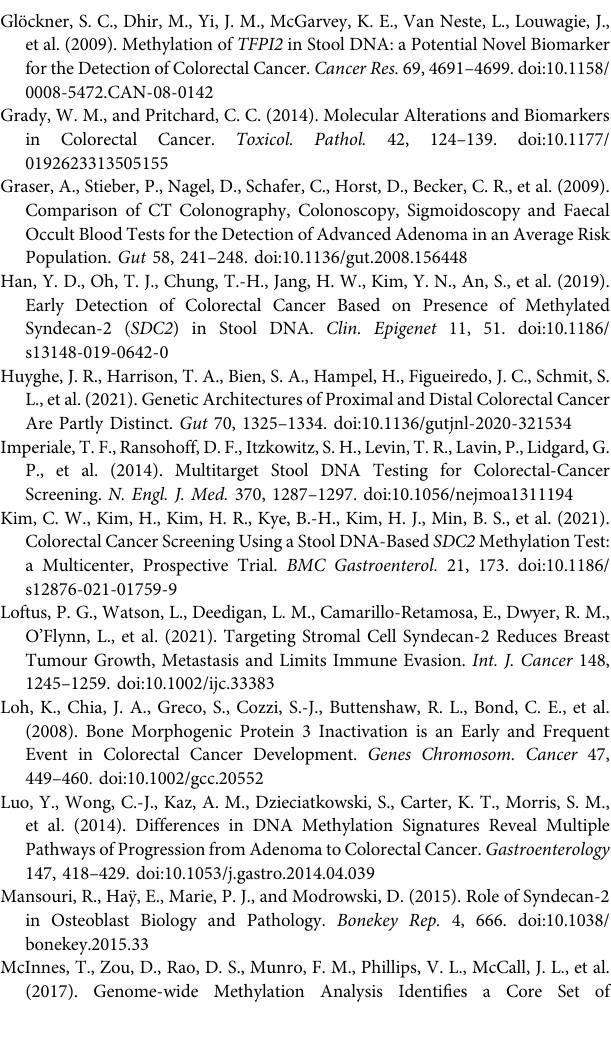
Supplementary Figure S2 | PCR ampli fi cation curves of the positive and negative standards for the target genes (SDC2 and TFPI2) and the endogenous reference geneACTB.(A)wasfromthepositive(red lines)and negative (black lines)controlsof plasmids, respectively. (B) was from cell lines of HT-29 and